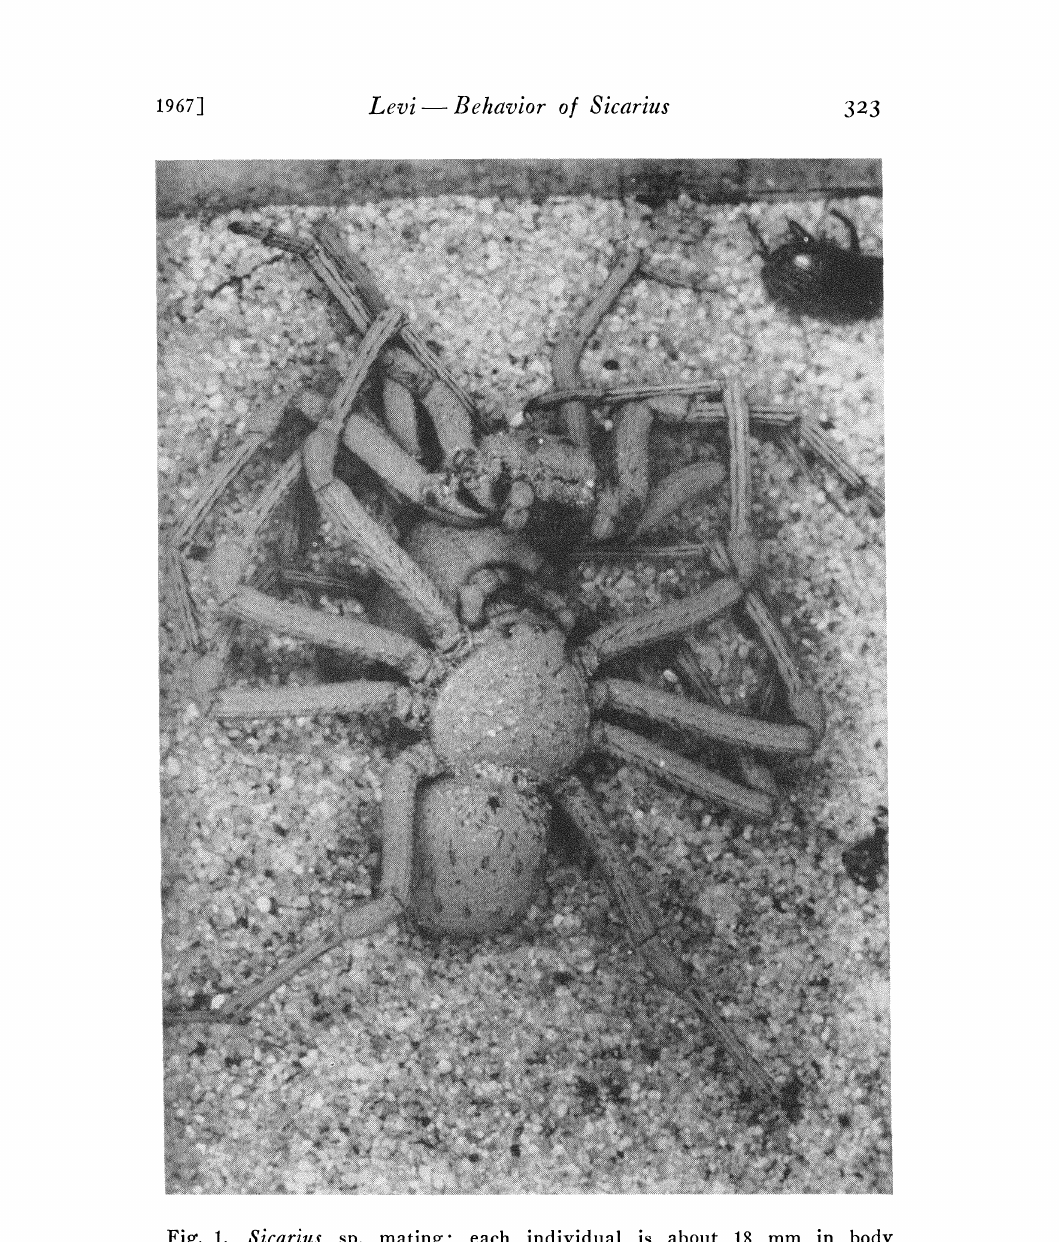
Fig. 1. Sicarius sp. mating; each individual is about 18 mm in body